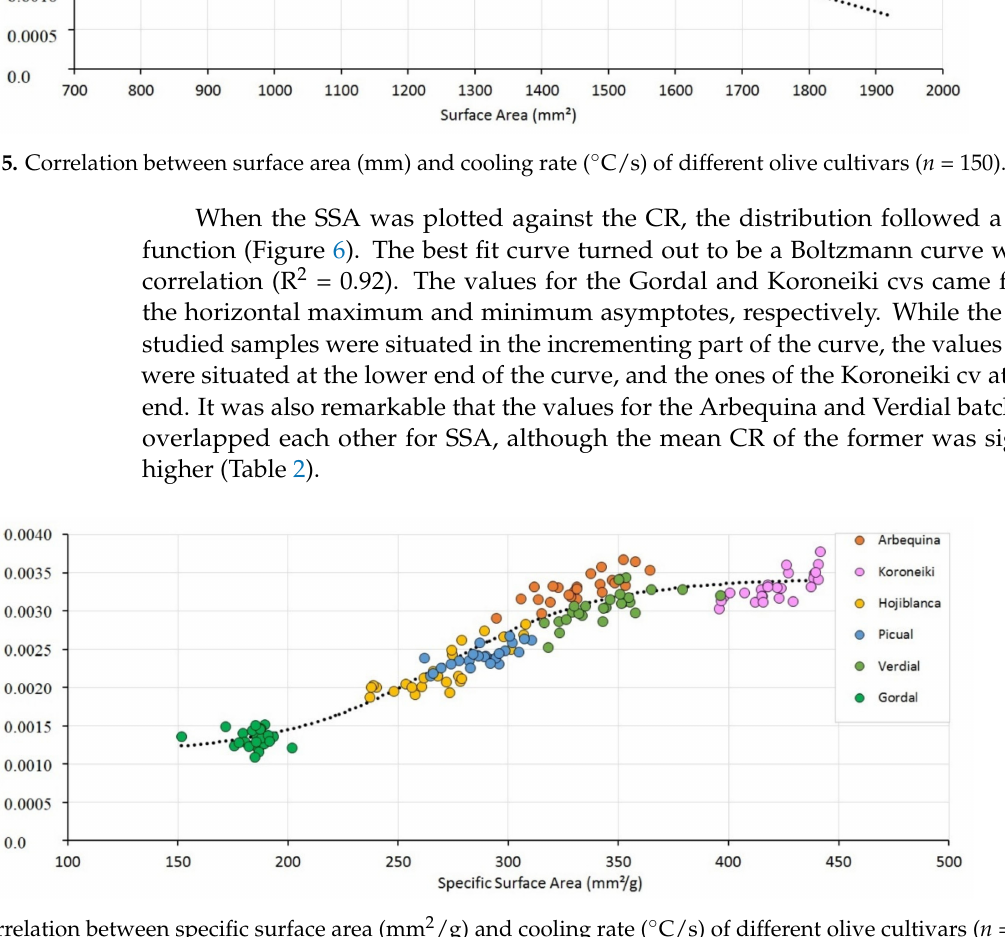
Figure 6. Correlation between specific surface area (mm 2 /g) and cooling rate ( ◦ C/s) of different olive cultivars ( n =